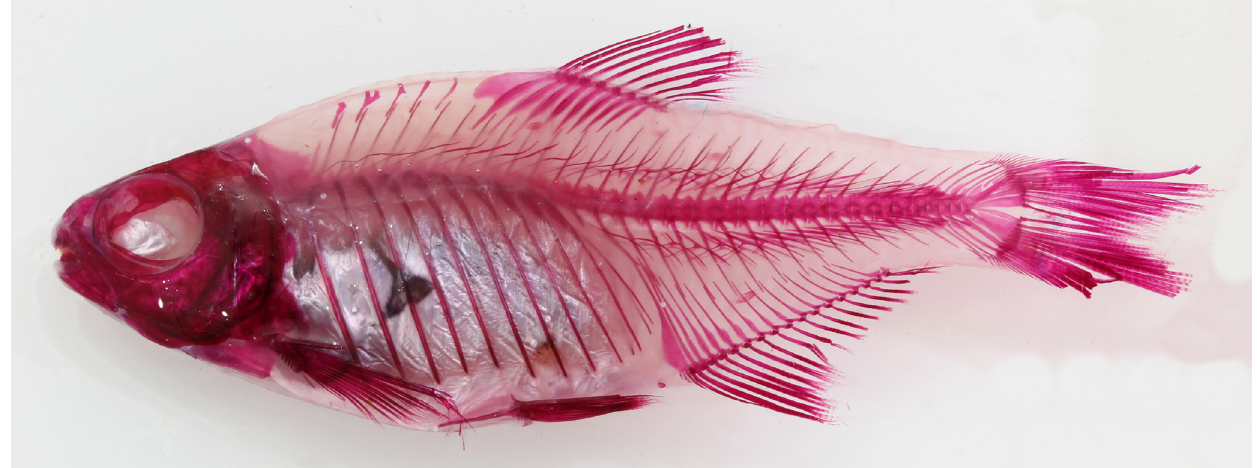
FIGURE 8 | Knodus obolus , c&s paratype, CPUFMT 6837, 50.3 mm